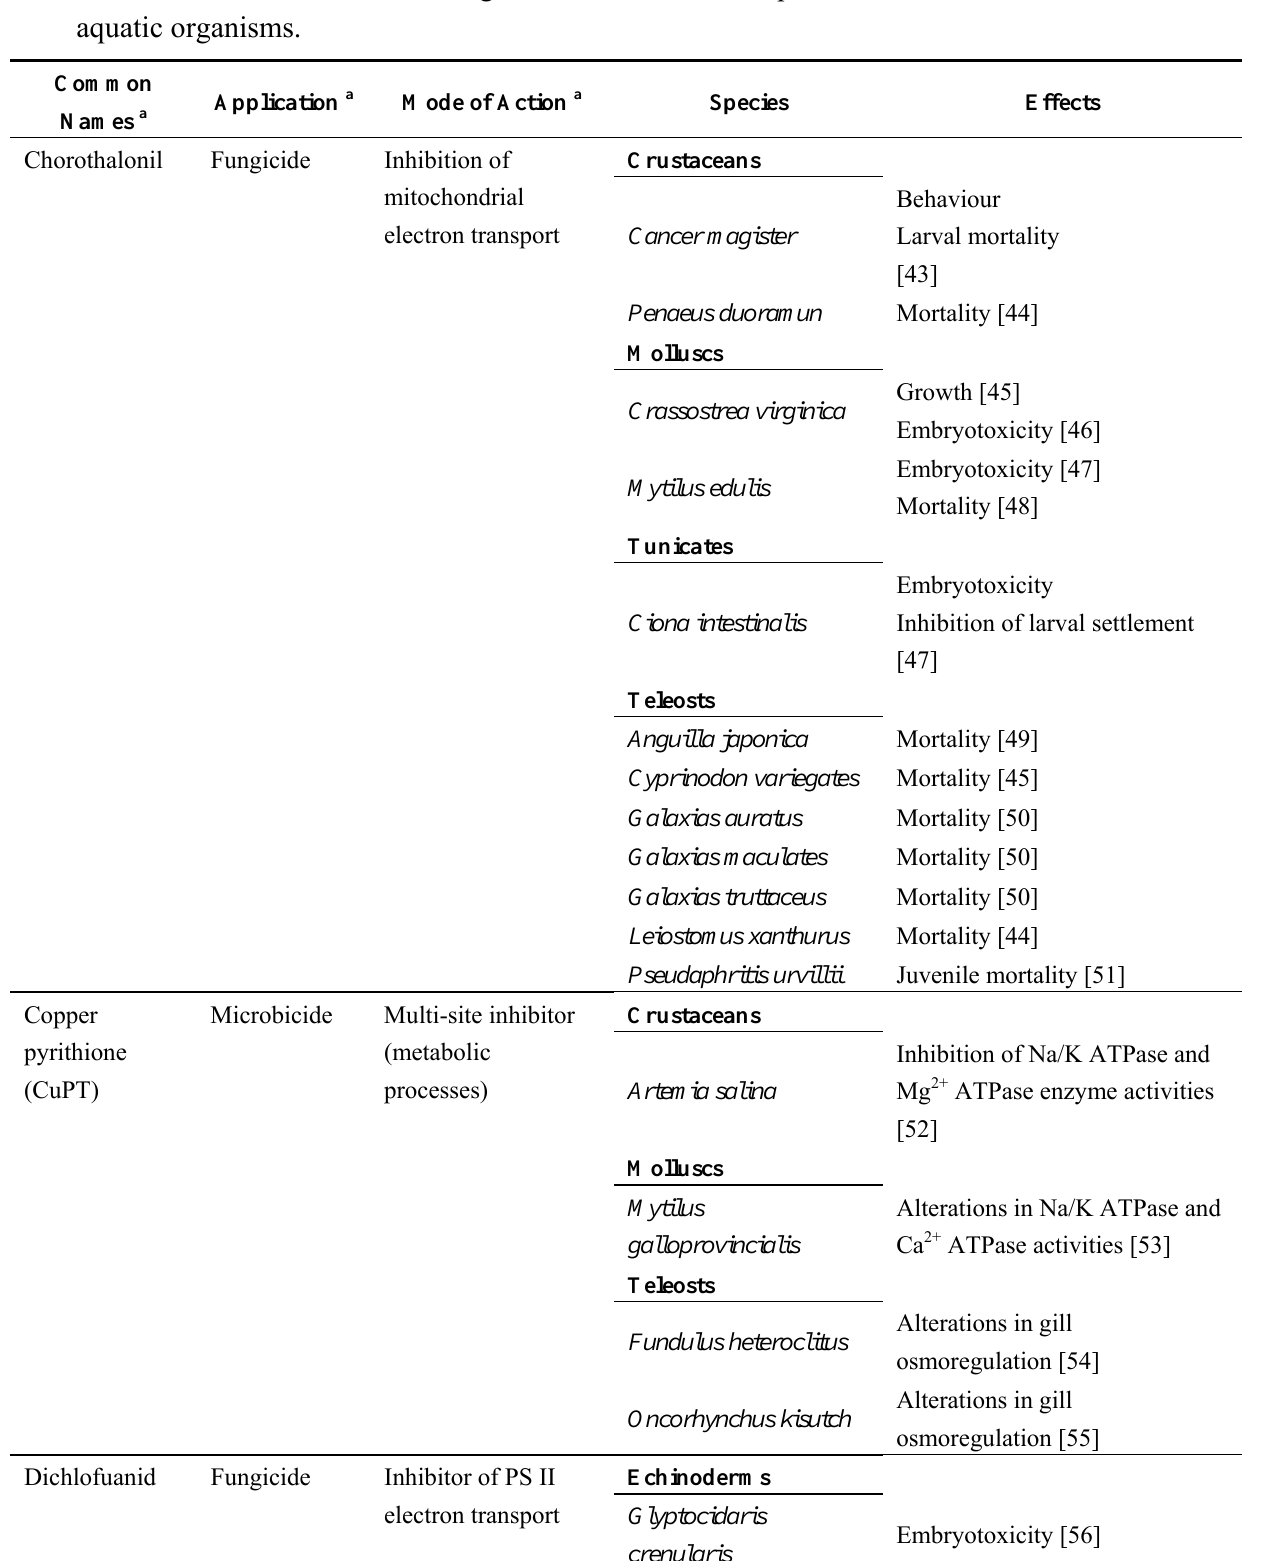
Table 1. The main antifouling biocides used in aquaculture and their effect on aquatic